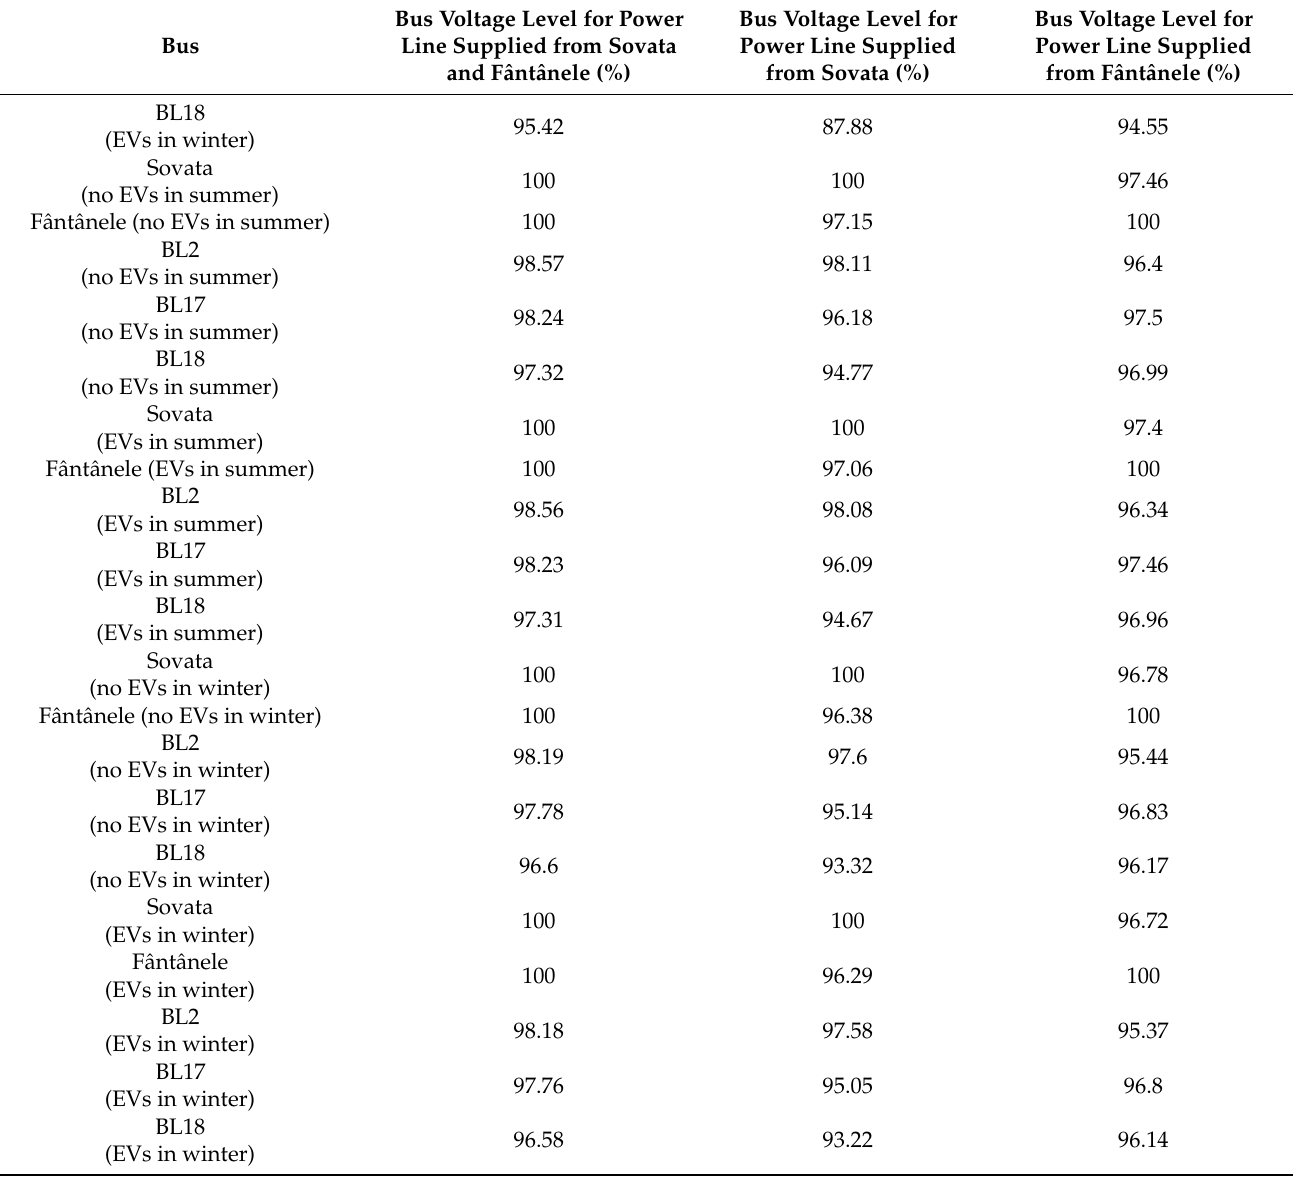
Table 35. Voltage level at 23:00 (scenario